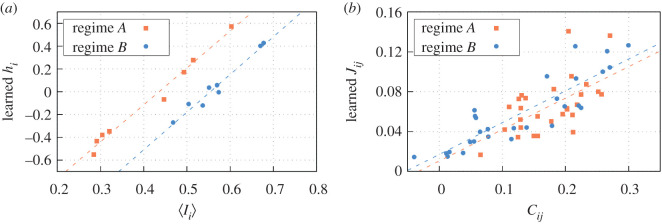
(a) Averaged experimental occupancy for each node 〈Ii〉 in comparison to the learned external field hi. The correlation coefficients are C = 0.991 for the regime A dataset (orange) and C = 0.982 for the regime B dataset (blue). (b) Experimental correlation between the nodes i and j, Cij, in comparison to the learned pairwise interaction Jij. The correlation coefficients are C = 0.597 for the regime A dataset (orange), and C = 0.876 for the regime B dataset days (blue).